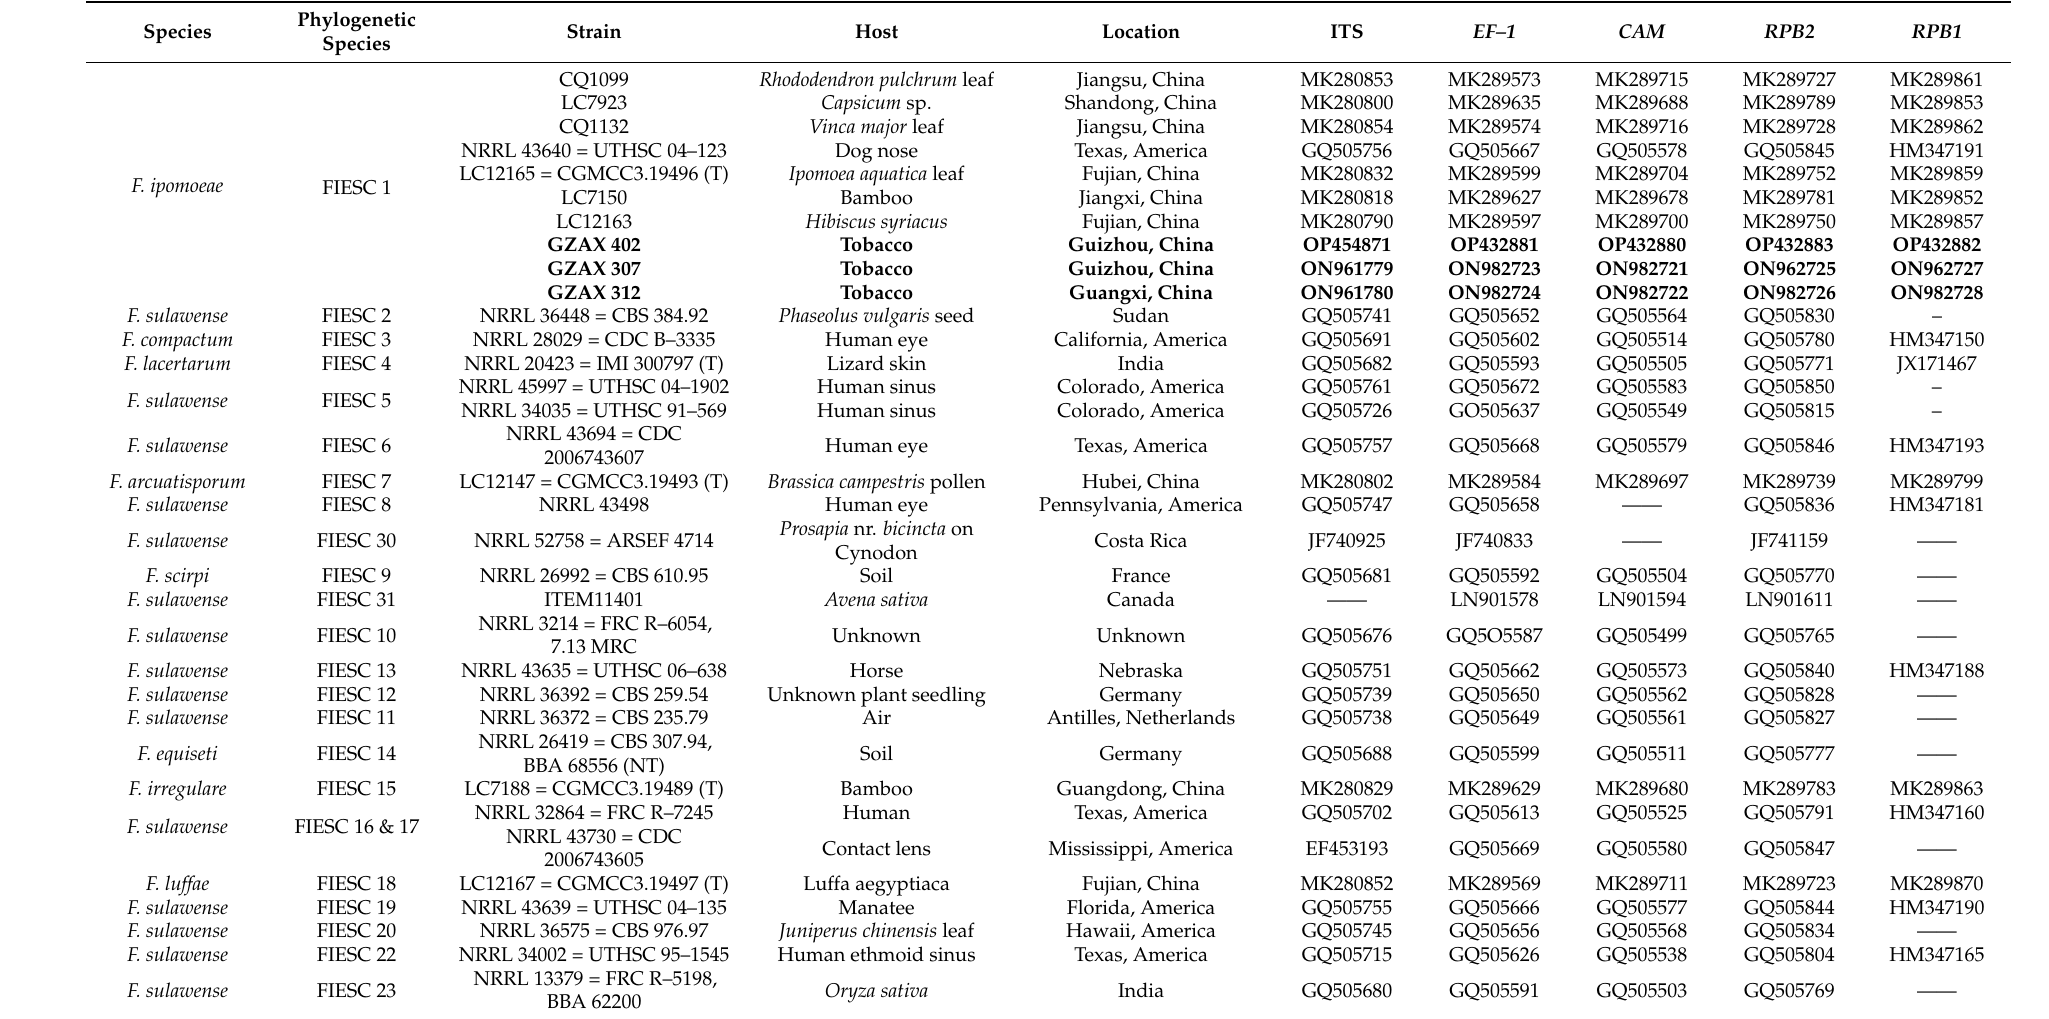
Table 1. Strains used in the phylogenetic analyses and their GenBank accession